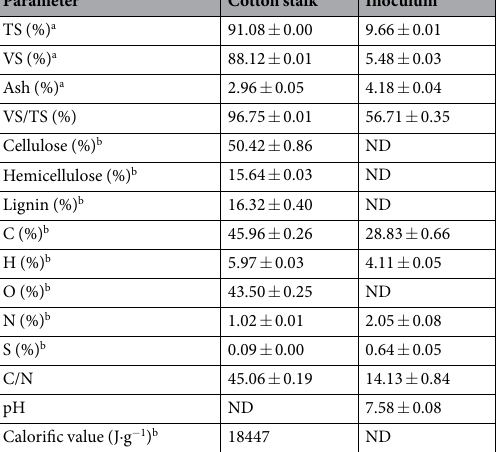
Table 1. Basic characteristics of CS and inoculum c . c Results are the average and their standard error of triplicate measurements. a As total weight of sample; b as TS of sample; ND = not